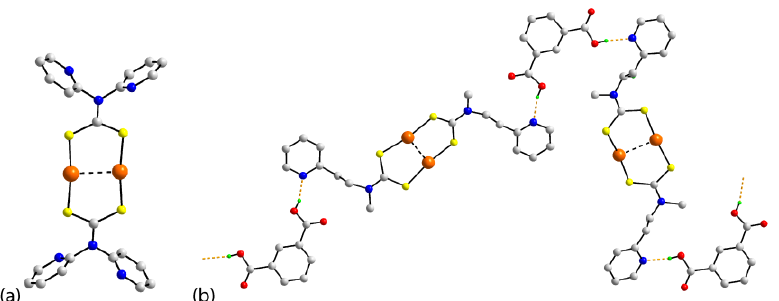
Figure 5. ( a ) Molecular structure for [Au(L 7 )] 2 ( 20 ) and ( b ) supramolecular aggregation in the crystal of 21 , being a 1:1 co-crystal of [Au(L 12 )] 2 and isophthalic acid. Additional color code: oxygen, red. The orange dashed lines indicate hydroxyl-O–H · · · N(pyridyl) hydrogen bonds leading to a twisted supramolecular chain.